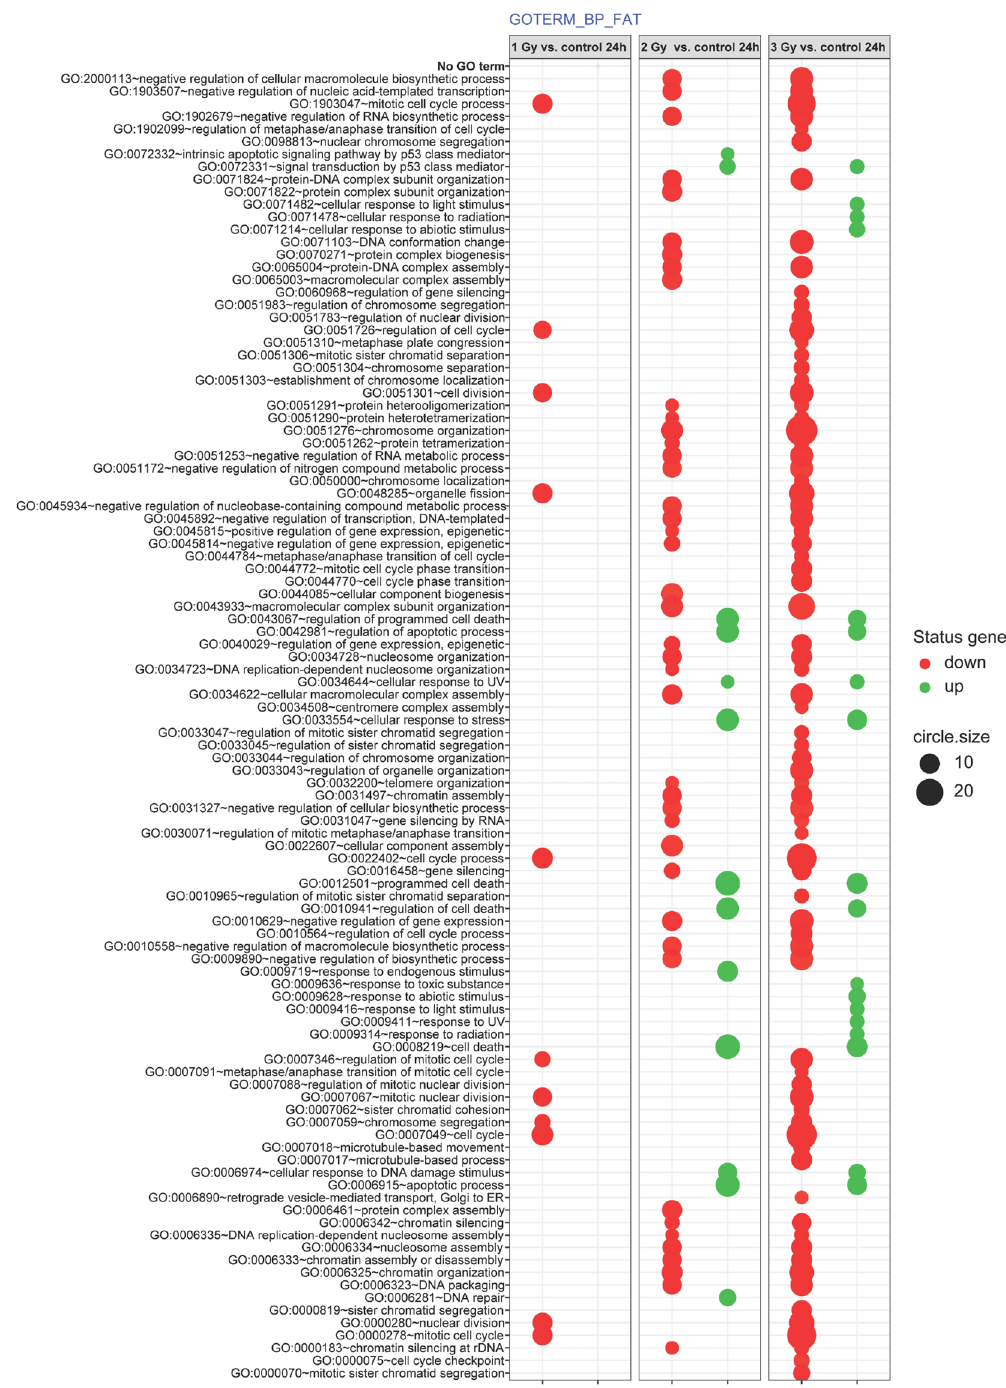
Figure 3. Bubble plot of differentially-expressed genes from each group (1 Gy vs. controls; 2 Gy vs. controls; 3 Gy vs. controls) assigned to gene ontology (GO) terms where the red color represents GO terms whose genes are downregulated while green corresponds to GO terms of upregulated